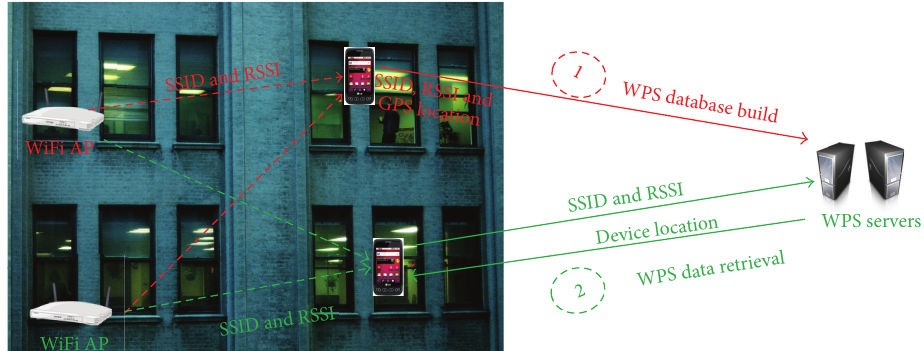
Figure 2: Illustration of WiFi positioning system.